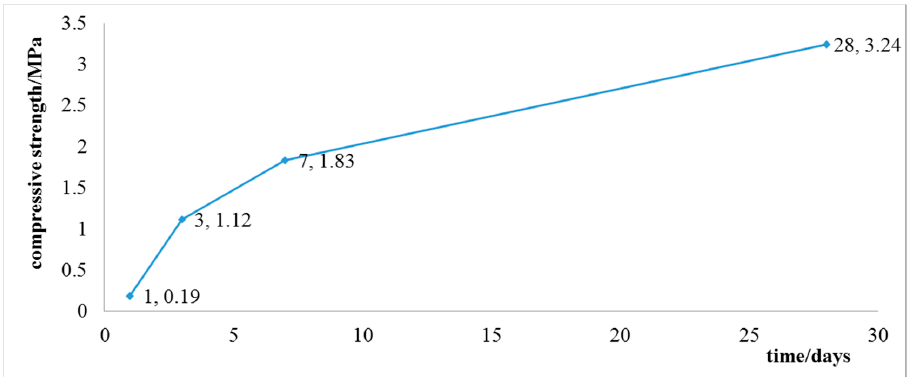
Figure 4. Backfill mass strength with time. Processes 2018 , 6 , x FOR PEER REVIEW